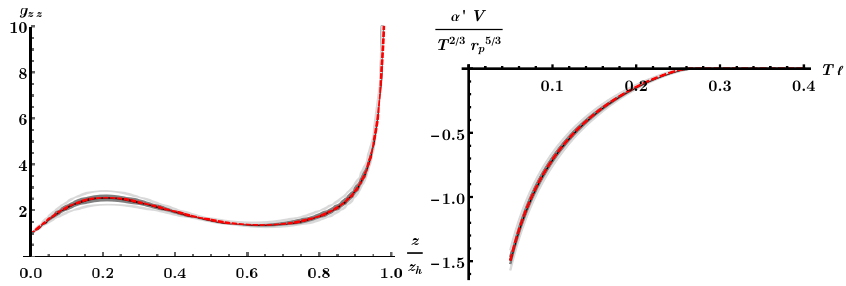
Figure 3. Left: One of the metric components as reconstructed from the SU(2) lattice data for ∂ (cid:96) S EE at T / T c = 2 . 646. Right: The prediction for the static quark potential given the metric on the left. In these plots the dashed curve is the maximum likelihood estimate of the data. The black dashed curve is the median in the distribution of g zz while the dashed gray curves represent the 50% and 95% central confidence intervals,